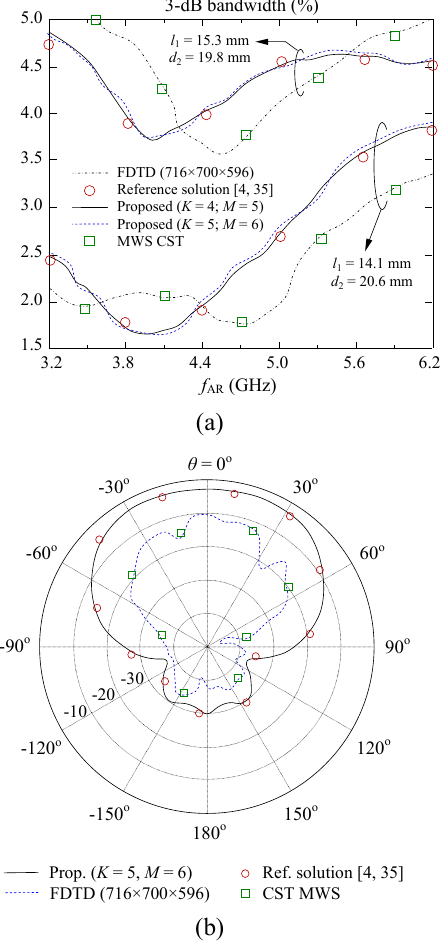
Figure 15: (a) 3-dB bandwidth versus axial ratio frequency and (b) radiation pattern for the hemi-ellipsoidal